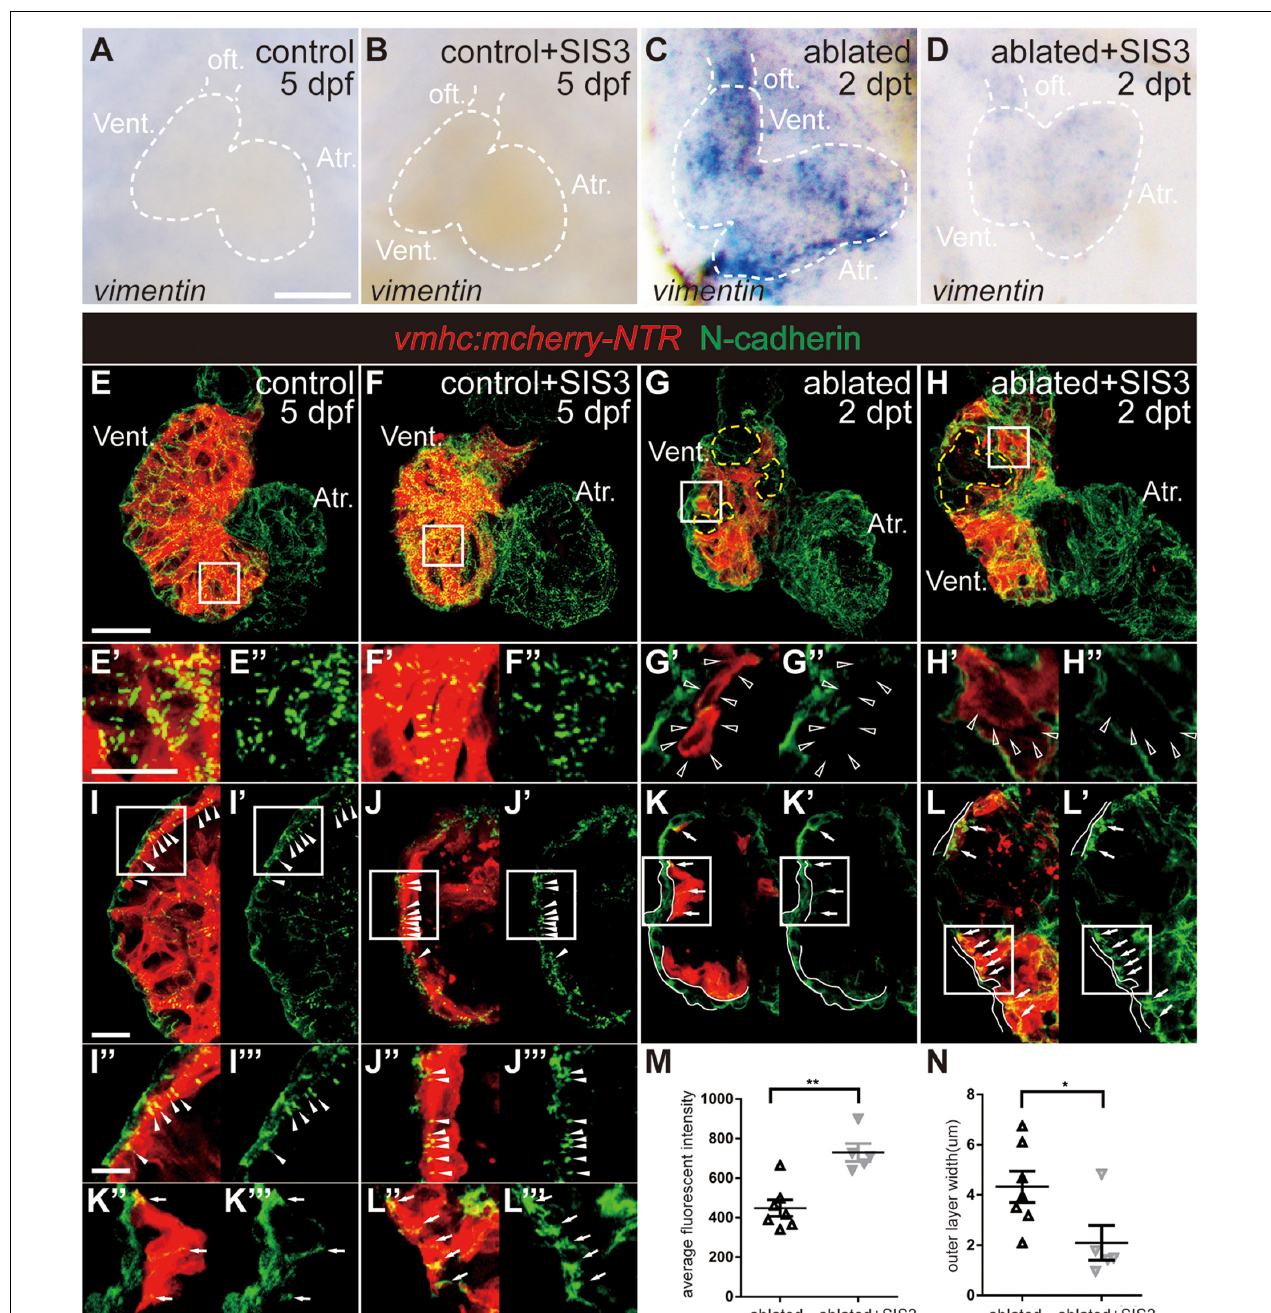
FIGURE 6 | Smad3 inhibition affects vimentin and N-cadherin expression during regeneration. (A–D) Whole-mount in situ hybridization showing the expression level change of vimentin during regeneration. Smad3 inhibition via SIS3 treatment reduced the upregulation of vimentin at 5 dpf/2 dpt. Dashed lines outline the hearts. (E–H (cid:48)(cid:48) ) Maximal projection images of Tg(vmhc:mCherry-NTR) hearts showing surface view of N-cadherin immunostaining (green) in the control or ablated hearts without or with SIS3 treatment at 5 dpf/2 dpt. (E (cid:48) –H (cid:48) ) Enlargement of box area in panels (E–H) . (E (cid:48)(cid:48) –H (cid:48)(cid:48) ) Green channel only. Yellow dashed lines outline the ablated areas; open arrowheads point to N-cadherin-absent CMs adjacent to the ablated areas. (I–L (cid:48)(cid:48)(cid:48) ) Optical section images of Tg(vmhc:mCherry-NTR) hearts showing the cross-section view of N-cadherin immunostaining (green) in the ventricle. (I (cid:48)(cid:48) –L (cid:48)(cid:48) ) Enlargement of box area in panels (I–L) . (I (cid:48) –L (cid:48) ,I (cid:48)(cid:48)(cid:48) –L (cid:48)(cid:48)(cid:48) ) Green channel only. Arrowheads point to regular punctate N-cadherin distribution; arrows point to irregularly dispersed N-cadherin distribution; white lines outline the outer layer without CM marker. (M) Quantification of average fluorescence intensity of N-cadherin immunostaining in the ablated hearts without or with SIS3 treatment at 5 dpf/2 dpt. N = 7 and 5, respectively. Mean ± s.e.m., Student’s t -test, two-tailed, ** P < 0.01. (N) Quantification of the outer layer width of N-cadherin immunostaining in the ablated hearts without or with SIS3 treatment at 5 dpf/2 dpt. N = 7 and 5, respectively. Mean ± s.e.m., Student’s t -test, two-tailed, * P < 0.05. Scale bars, (A–D) 50 µ m, (E–H) 20 µ m, (E (cid:48) –H (cid:48)(cid:48) ,I (cid:48)(cid:48) –L (cid:48)(cid:48)(cid:48) ) 5 µ m, (I–L (cid:48) ) 10 µ m. dpf, days post-fertilization, dpt, days post-treatment; atr., atrium; oft., out flow tract; vent., ventricle; CM, cardiomyocyte.